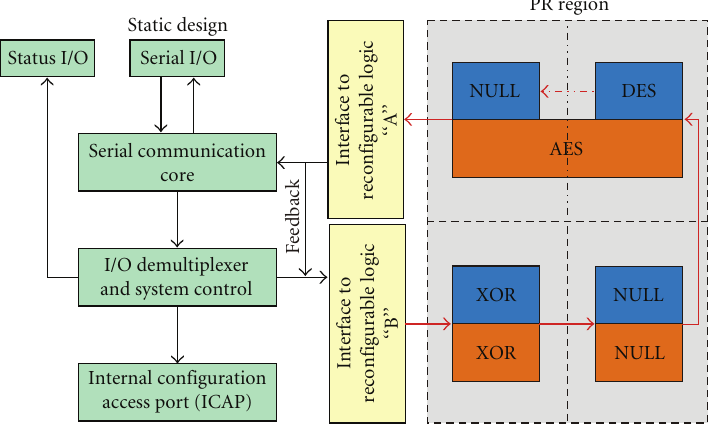
Figure 3: Example design.